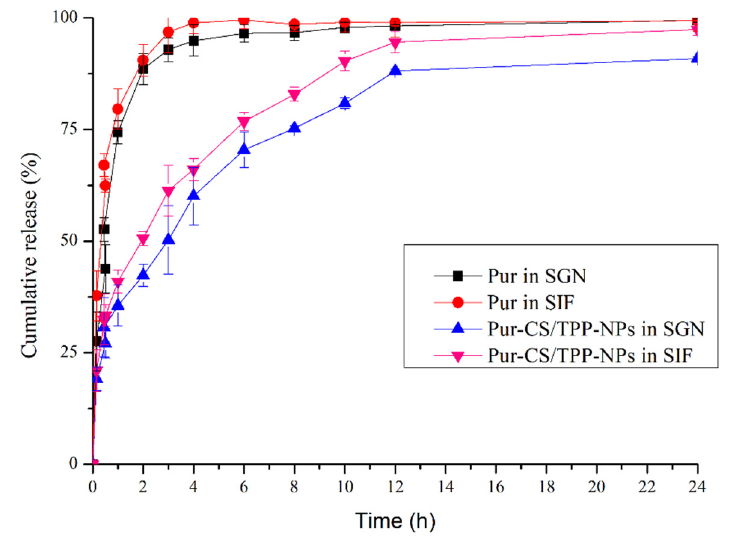
Figure 3. Accumulated release of Pur and Pur-CS/TPP-NPs under artificial gastric juice (SGN) and artificial intestinal fluid (SIF), respectively ( n = 3, ⎯ x ± s).